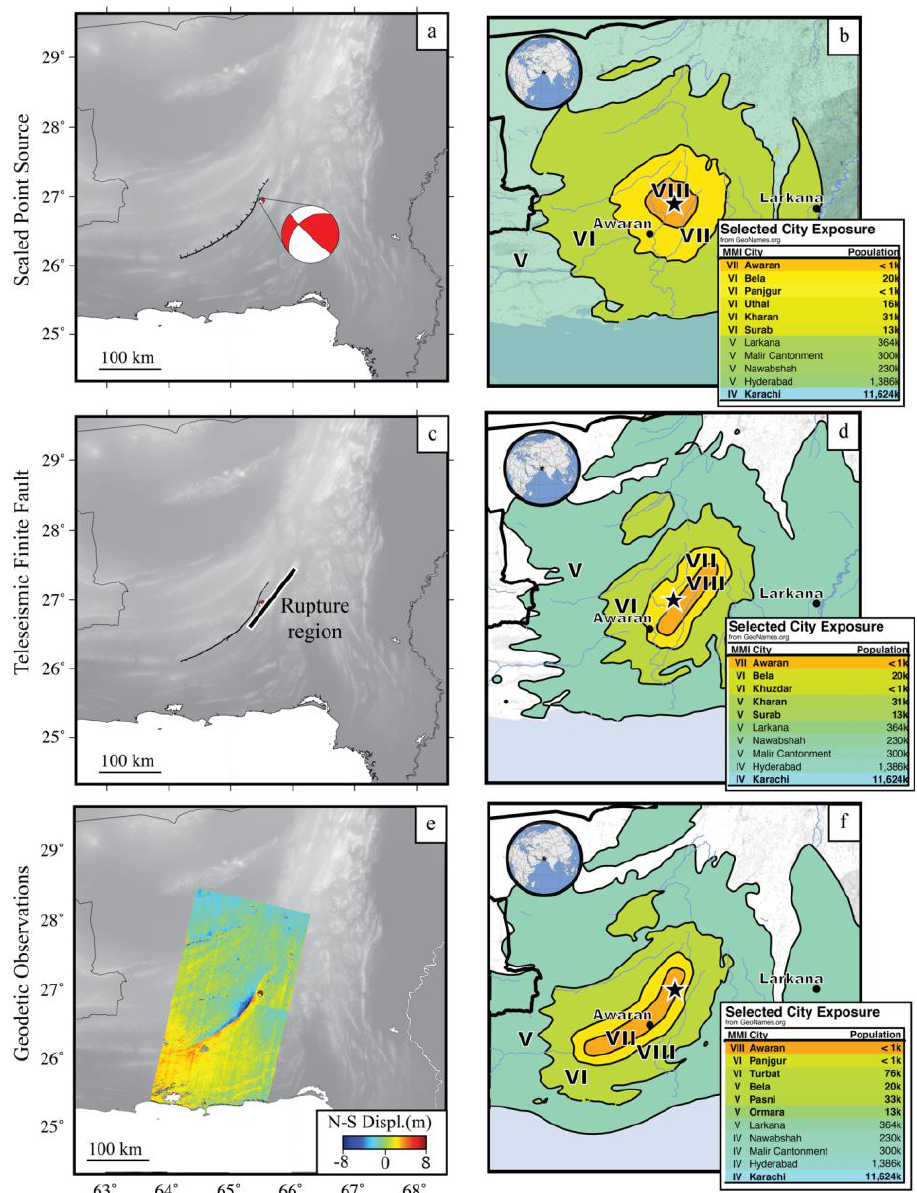
Figure 6. Examples of the evolution of NEIC PAGER reports following the 2013 Baluchistan, Pakistan earthquakes. ( a , b ) Initial earthquake location and W-phase moment tensor solution with the corresponding PAGER report that used a scaled point source solution. The black trace in panel ( a ) depicts the rupture trace of the earthquake [56], and the tick marks indicate the dip direction of the fault. The PAGER map in panel b shows the expected MMI intensity exposure of different population centers. ( c , d ) Preliminary teleseismic finite fault model and corresponding PAGER report. The finite fault model is spatially tied to the initial event location in panel ( a ). ( e,f ) Landsat-8 pixel tracking results spanning the Baluchistan earthquake, shown here with north-south displacements, and the corresponding PAGER report. The PAGER report is informed by the rupture fault trace apparent in the pixel tracking results. Roman numerals indicate the expected MMI shaking